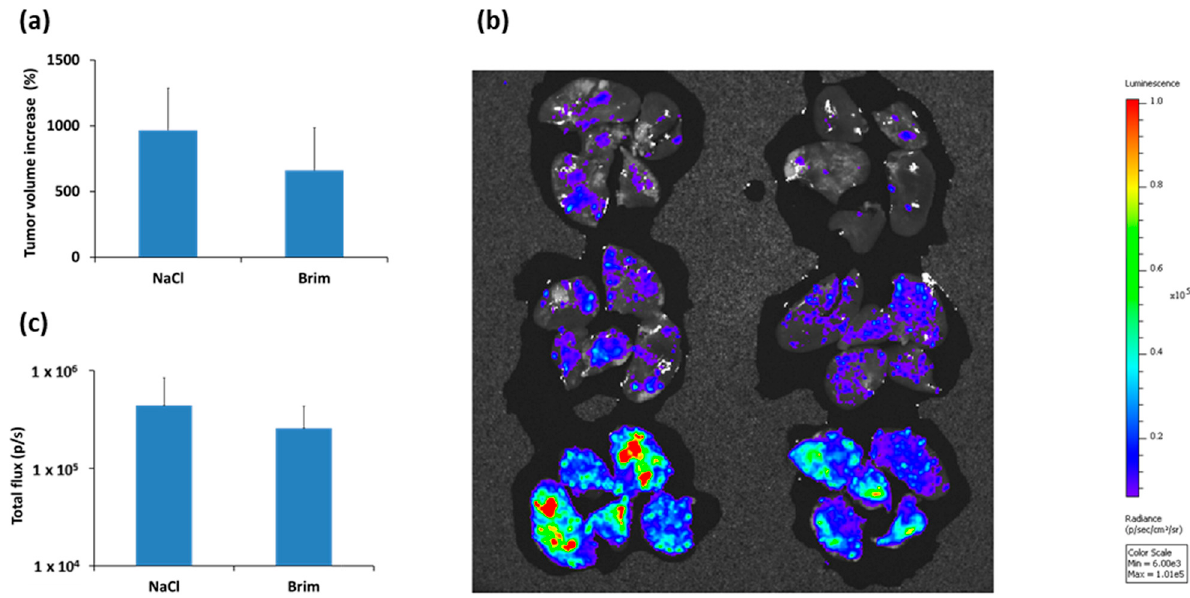
Figure 5. Antimetastatic activity of brimamin in the DLD-1 tumor model. Nude mice bearing s.c. xenograft tumors of luciferase-expressing DLD-1 were treated with NaCl (control) or brimamin (20 mg/kg BW) on days 0, 7, 14, and 21. ( a ) The tumor volume increase on day 25 relative to the start of treatment on day 0 is shown, as mean values ± SD ( n = 3). ( b ) Ex vivo analysis of lung metastasis using bioluminescence imaging. ( c ) Quantification of metastatic burden given as total flux (photons per seconds).